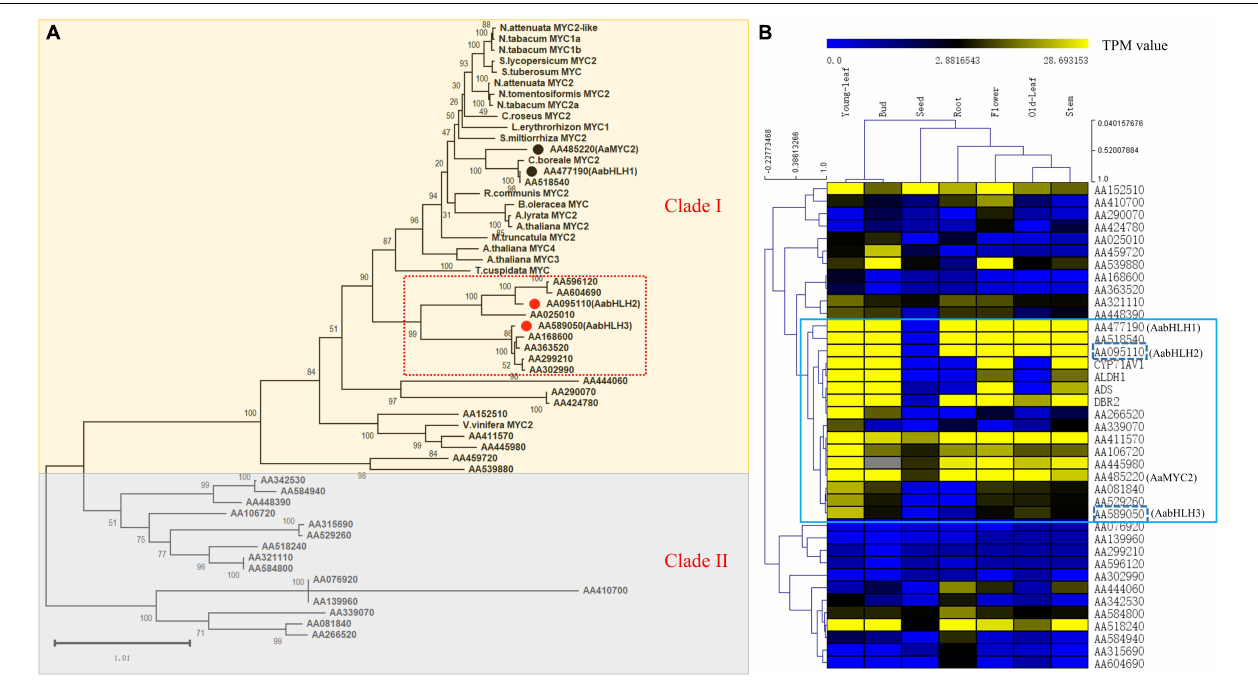
FIGURE 1 | Phylogenetic analysis and global gene expression of MYC-type transcription factors in A. annua . (A) Phylogenetic tree analysis of MYCs transcription factors in A. annua with other plants MYCs. (B) Gene co-expression analysis of the MYC transcription factor subfamily with artemisinin biosynthetic pathway genes in A.